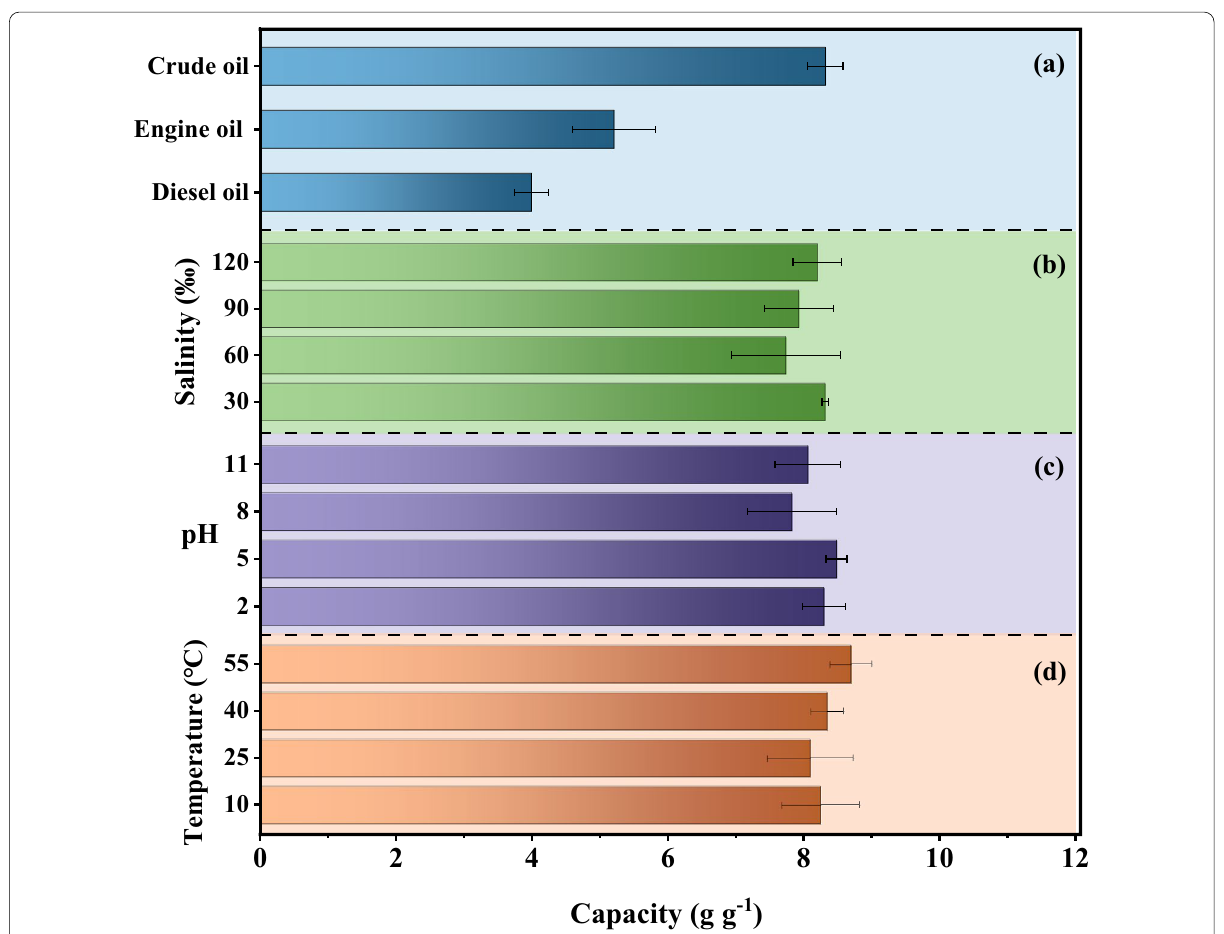
Fig. 9 Sorption of oils by OMBC in the seawater-oil system ( a ). Sorption of OMBC on crude oil under different conditions, salinity ( b ), pH ( c ), and temperature ( d )